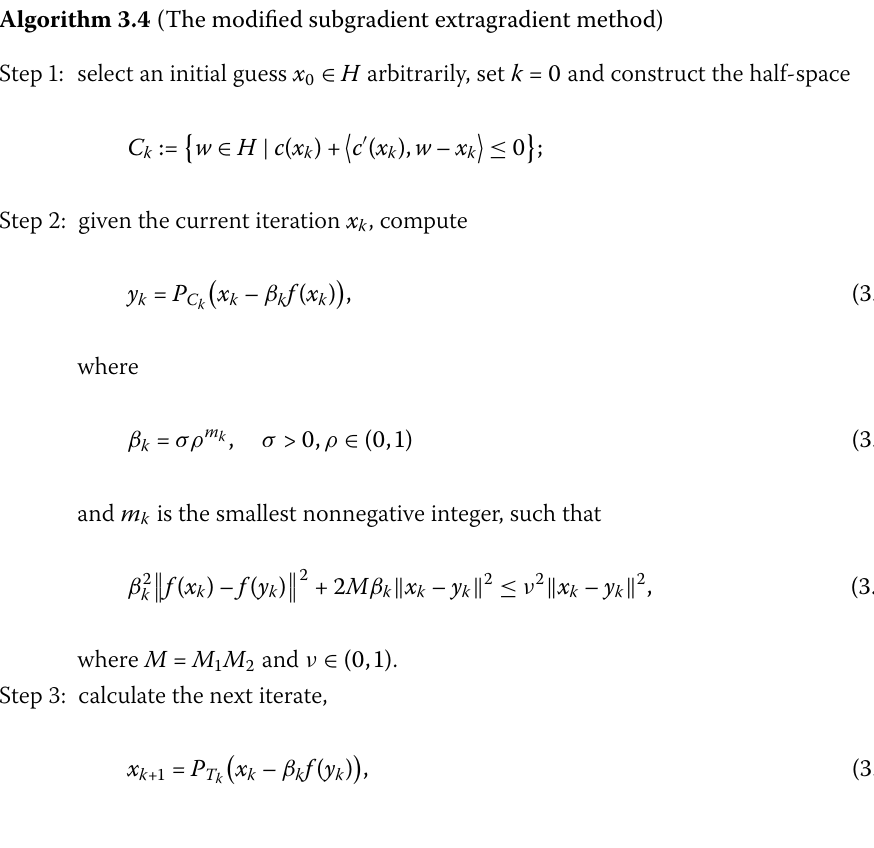
Algorithm . (The modified subgradient extragradient